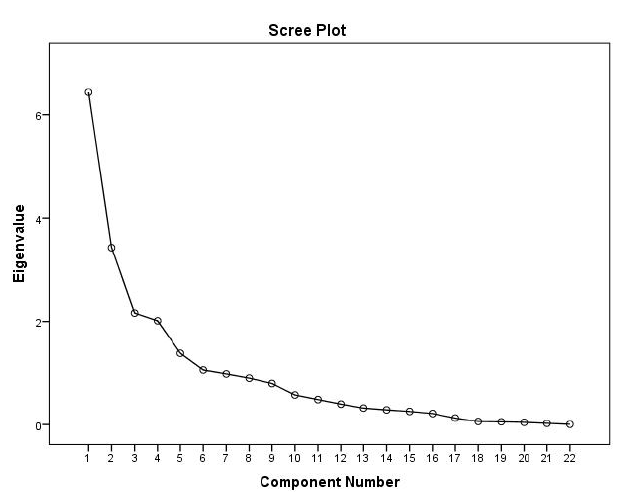
Figure A1. Scree plot of Factorial analysis. Source: The authors. Table A1. Results of the factor analysis. Total variance explained.